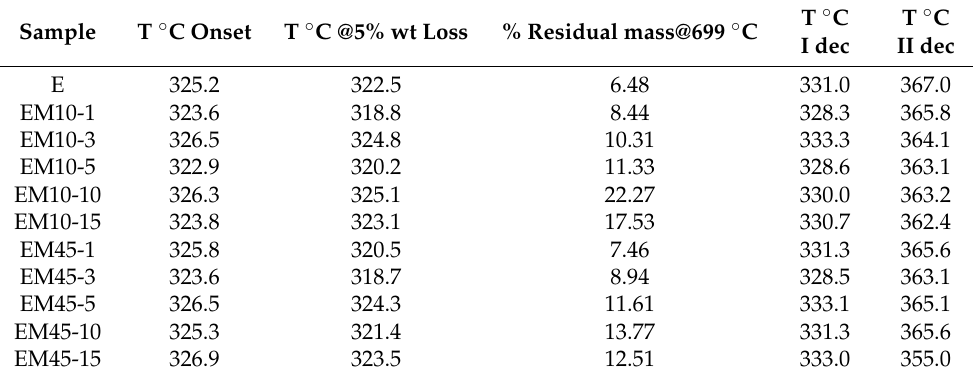
Table 2. Parameters from thermal analysis of pristine epoxy and mica-composites in N 2 . Sample